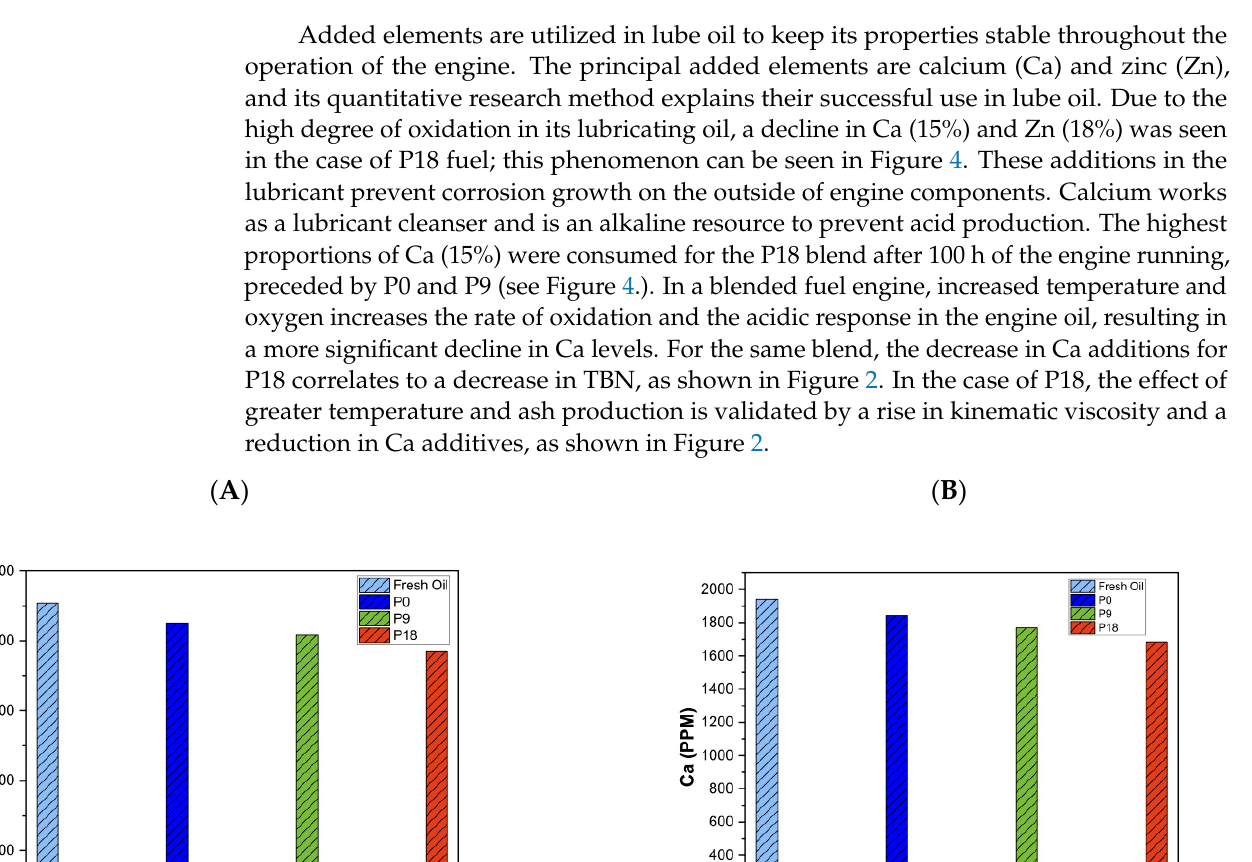
Figure 3 . Metal particles suspension in lubricant oil for test fuels.